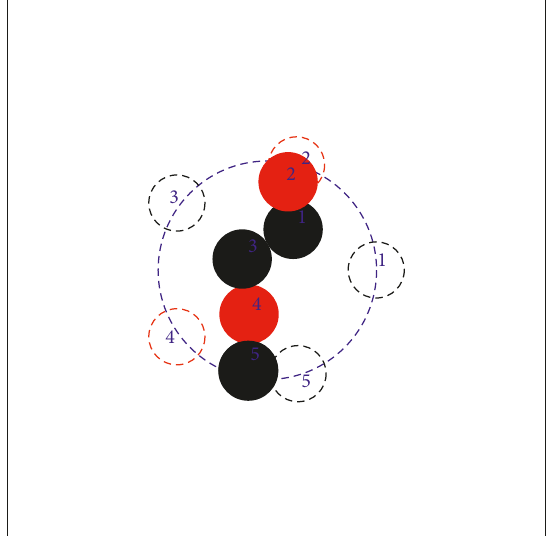
0, (b) θ 0 /16. (cid:31) (cid:31) π